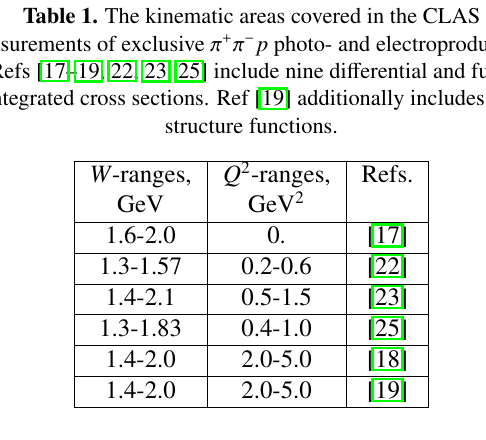
Table 2. The values of χ 2 / d . p . from the comparison between the nine one-fold di ff erential γ v p → π + π − p cross sections measured and computed within the updated JM model.